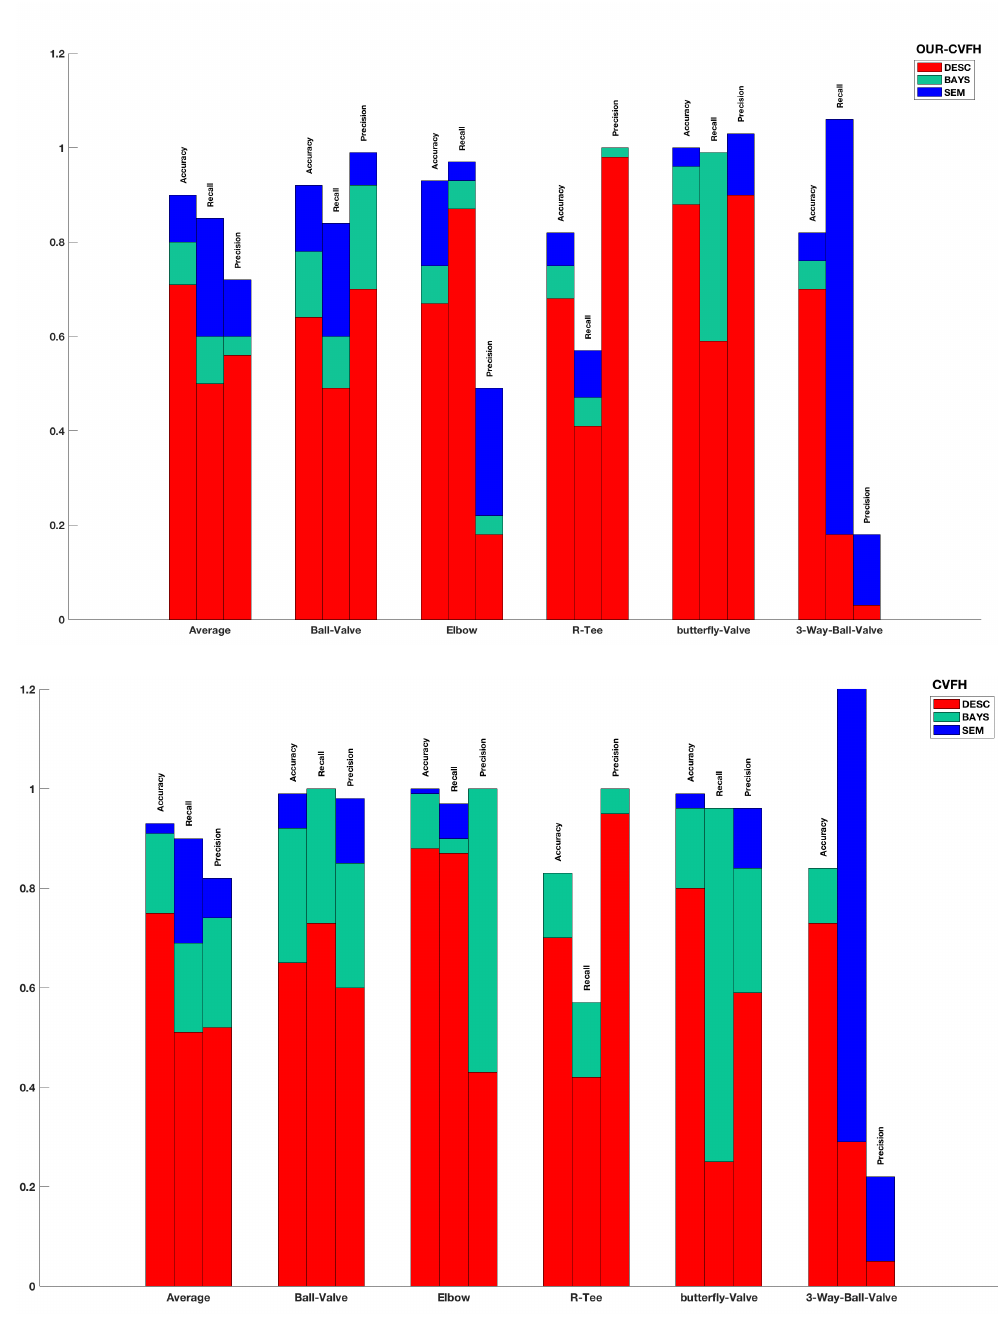
Figure 14. Evaluation of the recognition performance using Accuracy, Recall and Precision for descriptor-based, Bayesian-based and semantic-based method for both: ( Top ) OUR-CVFH; ( Bottom )